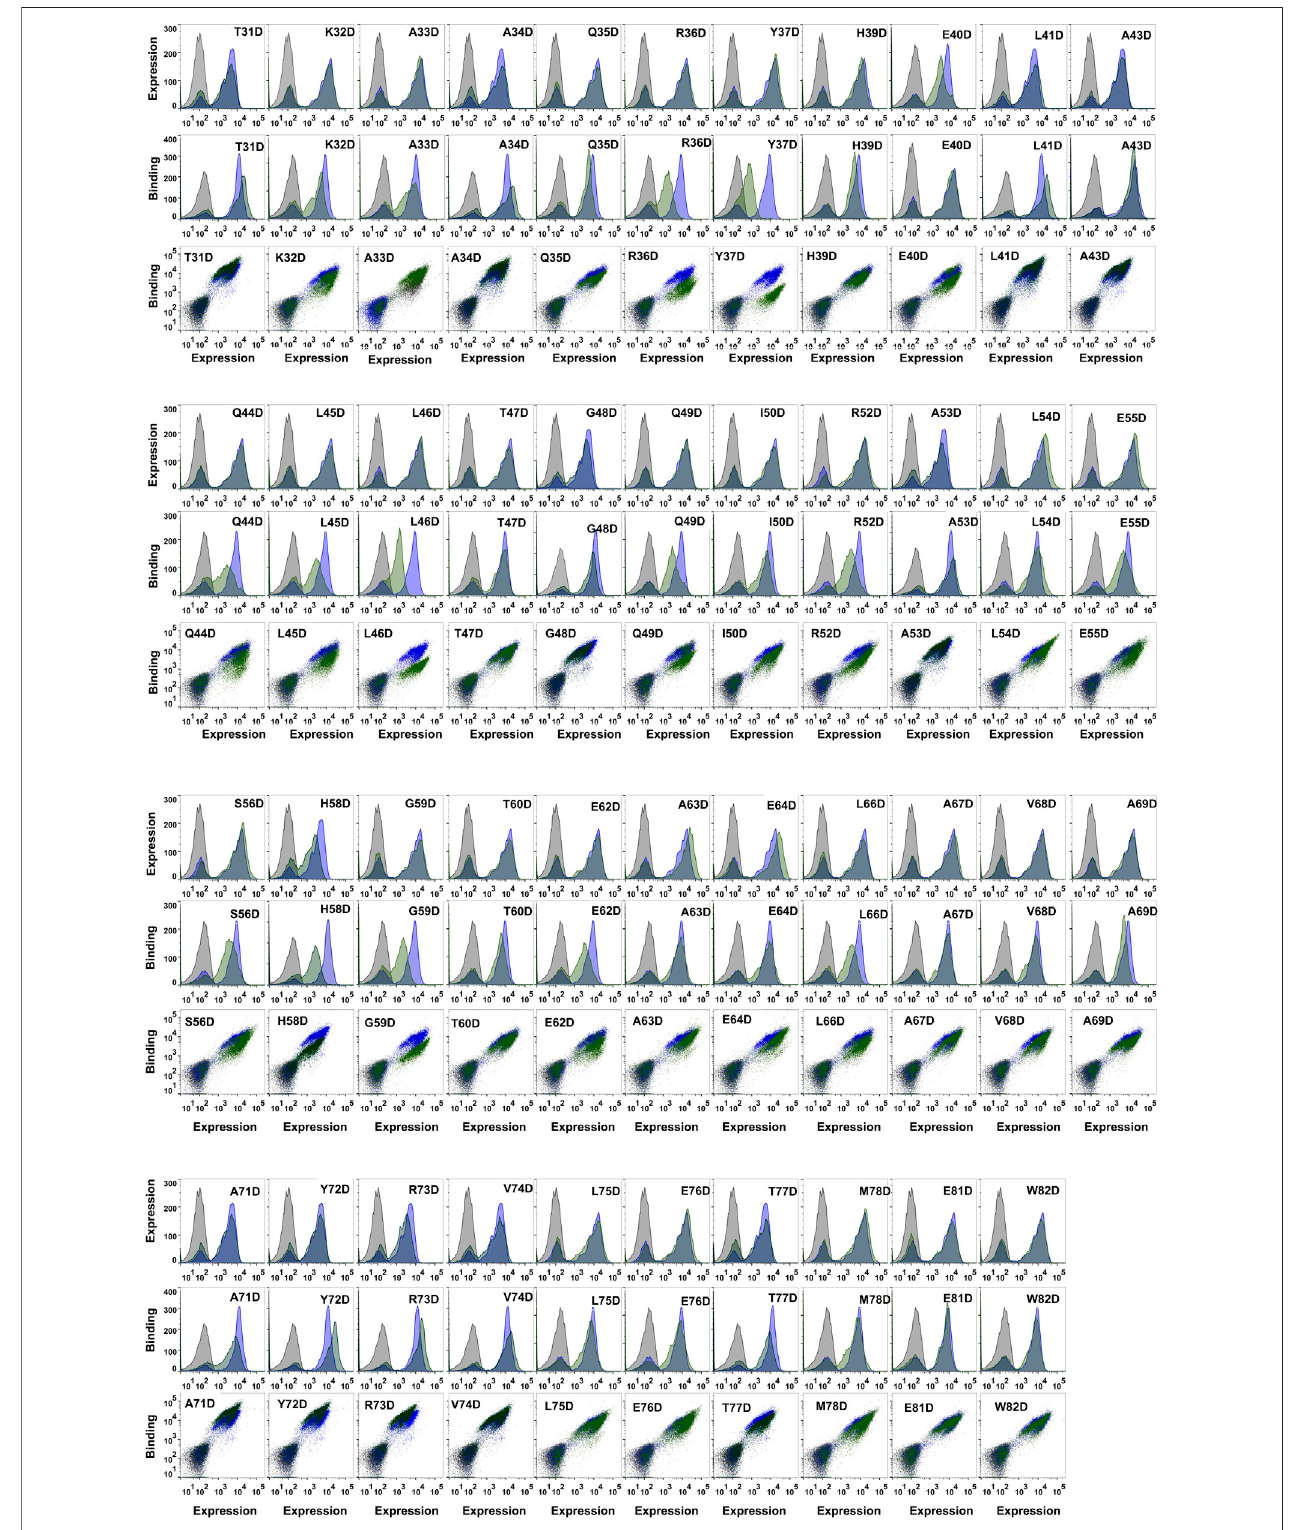
FIGURE 2 | Analysis of expression and MazF6 binding of different MazE6 aspartate mutants. Comparison of the surface expression and MazF6 binding of MazE6 aspartate mutants with that of the WT MazE6 on the yeast cell surface are shown. WT MazE6 histogram (blue) is overlaid with the histograms obtained for the mutants (green) in each of the plots. The uninduced cells are shown in grey.